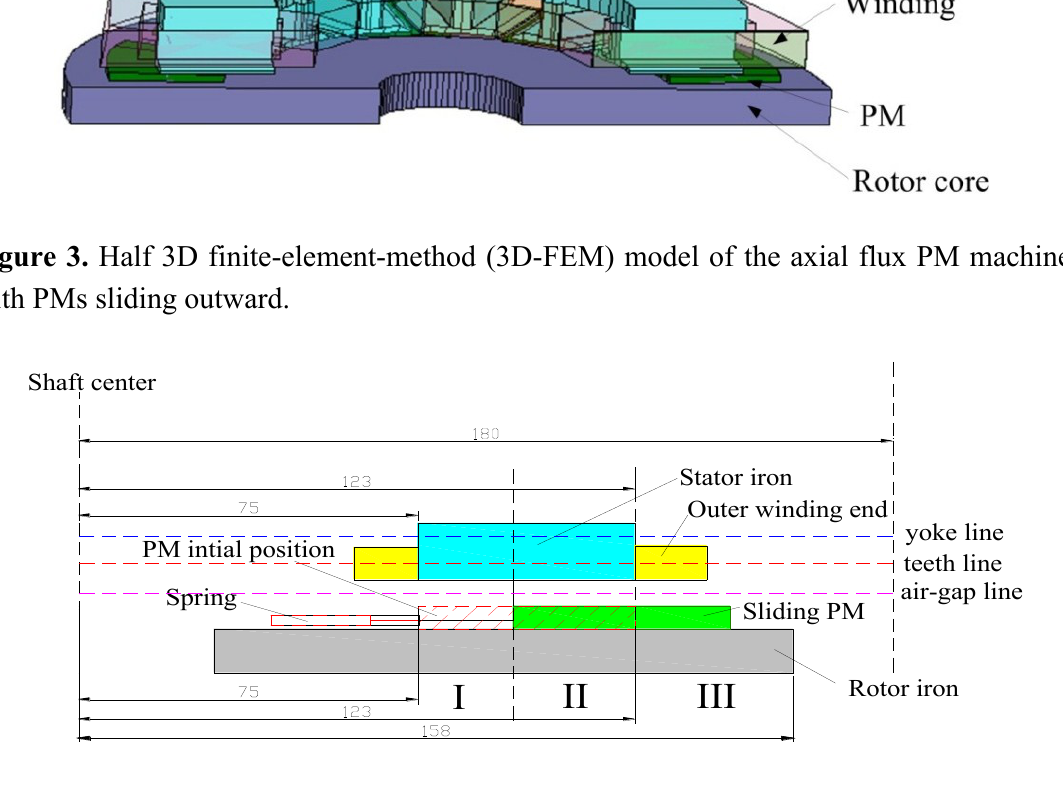
Figure 4. Cross diagram of radial section of the axial flux permanent-magnet synchronous machine (PMSM) when PMs slide